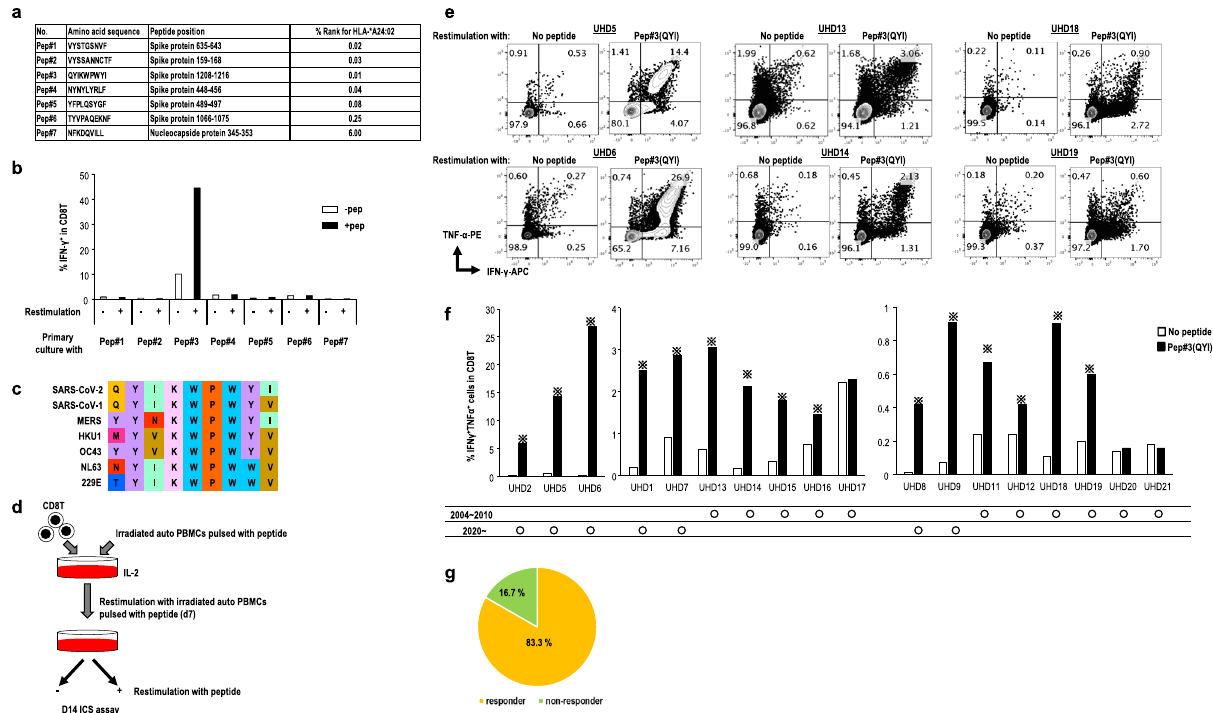
Fig. 1 SARS-CoV-2-speci fi c CD8 + T cell response in HLA-A24-positive unexposed healthy donors (UHDs). a Selected peptides for CD8 + T cells. Peptides derived from Spike (S) protein of SARS-CoV-2, shown in the list, were selected based on high-af fi nity binding (% rank) to HLA-A*24:02 via in silico prediction using NetMHC4.0. Pep#7 for nucleocapsid protein was selected as the control. b The data of IFN- γ + response of antigen-speci fi c CD8 + T cells from one representative donor (UHD2). PBMCs were stimulated with seven types of peptides individually, cultured for 3 weeks in the presence of IL-2, and then assessed for IFN- γ production following recall with their cognate peptide by intracellular cytokine analysis (ICS). c Homology of the reported epitope in the Pep#3 region of SARS-CoV-2 compared with that in other human coronaviruses. Identical residues are same color-coded. d Culture protocol of Pep#3(QYI)-speci fi c CD8 + T cell response. The sorted CD8 + T cells from PBMCs of HLA-A24 + UHDs were stimulated with irradiated autologous PBMCs pulsed with Pep#3(QYI). The Pep#3(QYI)-speci fi c CD8 + T cells were examined by the frequency of IFN- γ + TNF- α + CD8 + T cells by ICS analysis on day 14. e Flow cytometry data are shown for representative donors (UHD5, 6, 13, 14, 18, and 19) ( e ) and the frequency of IFN- γ + TNF- α + CD8 + T cells is summarized ( n = 18) ( f ). ※ responder (>1.5 fold change (restimulation + /restimulation − ) g Pie chart representing the proportions of responders or non- responders against Pep#3(QYI) in 18 HLA-A24 +